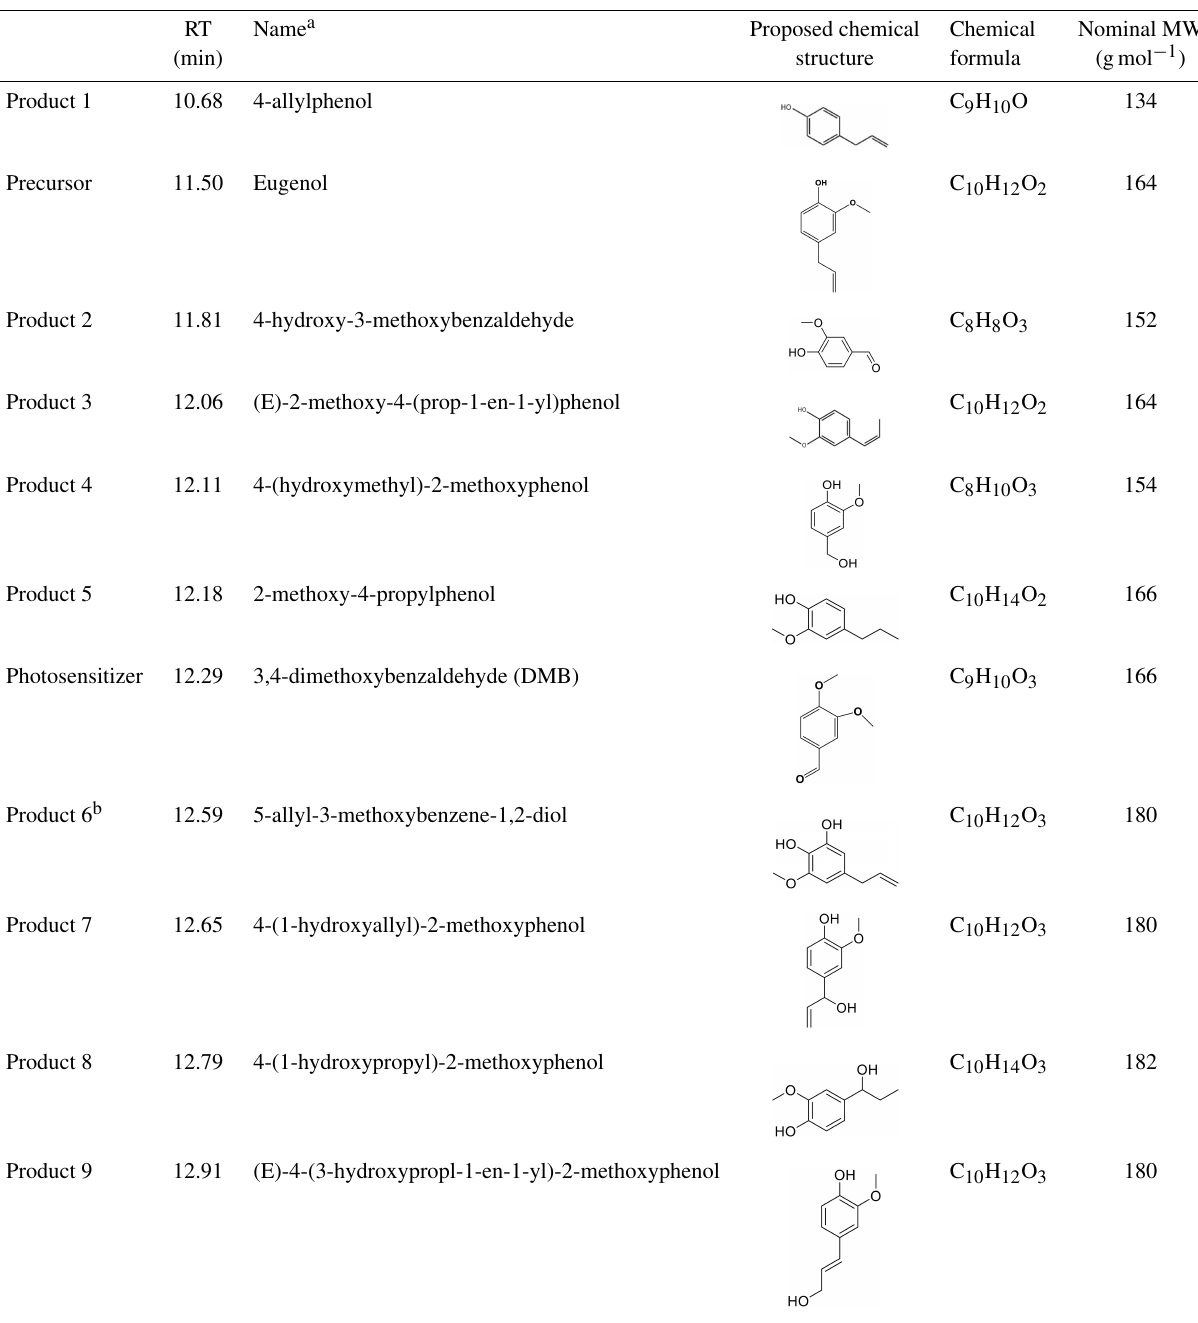
Table 2. Major reaction products identified via